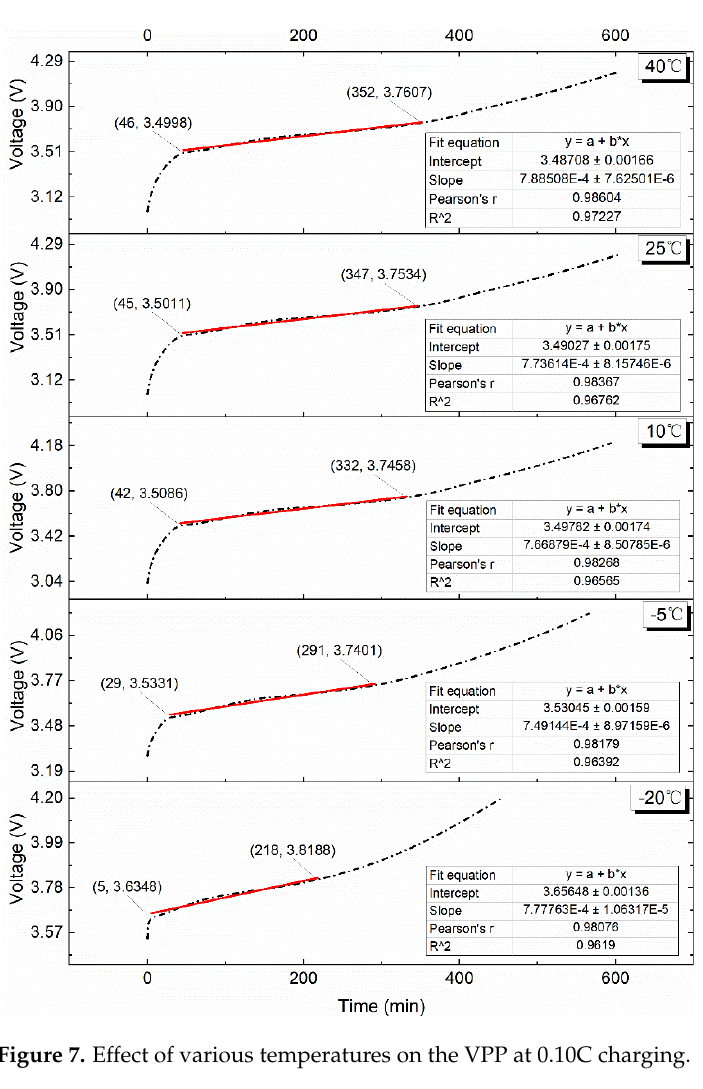
Figure 7. Effect of various temperatures on the VPP at 0.10C charging.